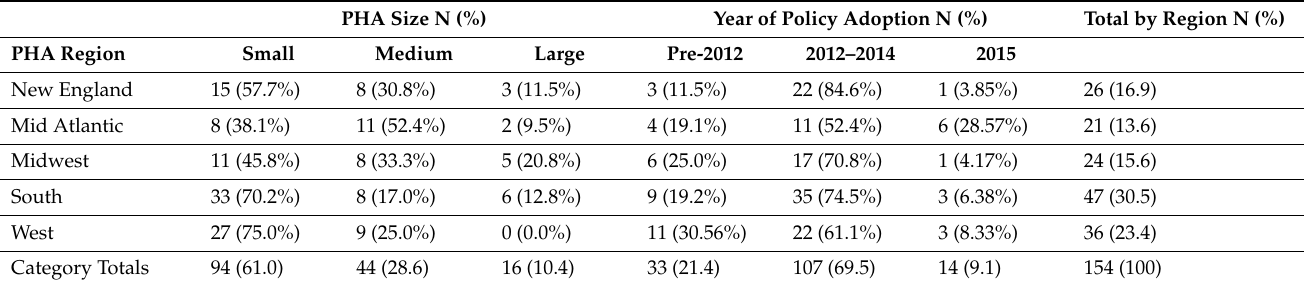
Table 2. Number (and percent) of participating PHAs by Region, Size, and Year of Adoption.